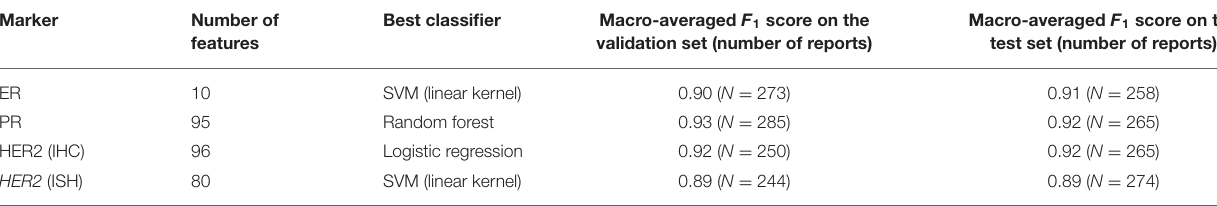
TABLE 2 | Results of the four classification tasks.